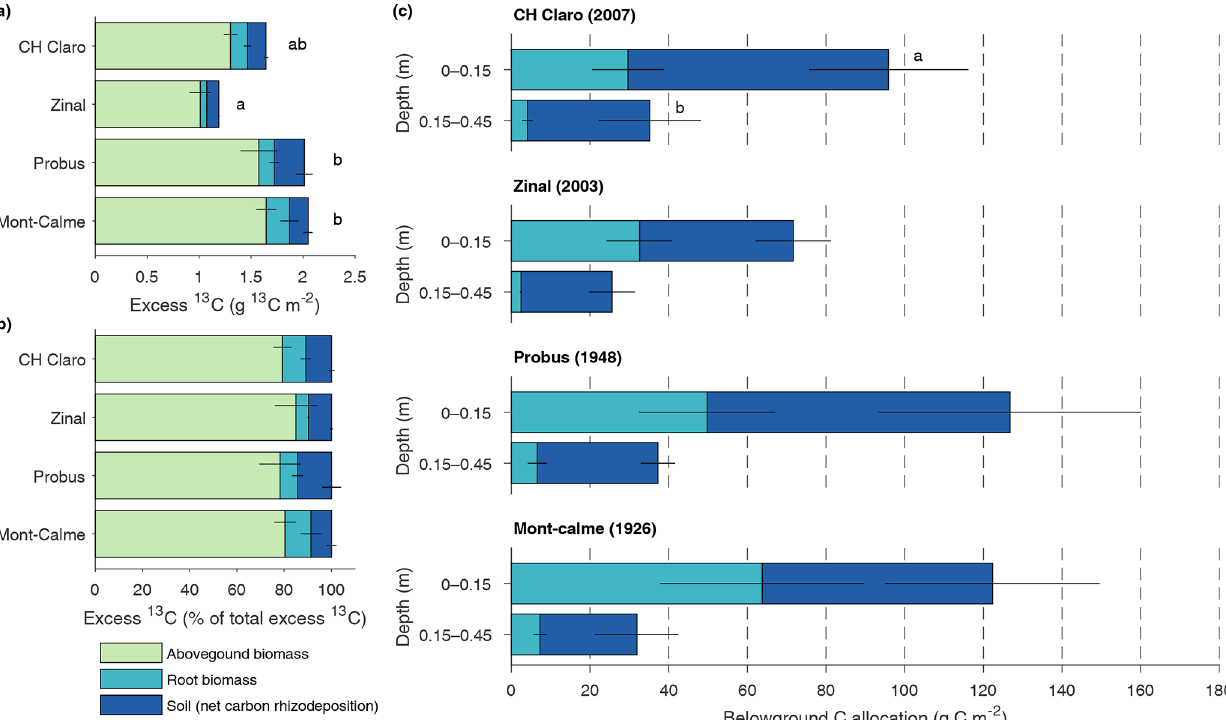
Figure 4. Absolute (a) and relative (b) distribution of excess 13 C between aboveground biomass, root biomass and soil for the different wheat cultivars. Soil compartments are calculated down to 0.45m depth. Panel (c) shows the total carbon rhizodeposition and root carbon for the upper two soil layers for the different wheat cultivars (0–0.45m depth). Error bars represent the standard error ( n = 3). In (a) , letters indicate significant differences between the total amount of excess 13 C of the different cultivars. No significant differences in the amount of excess 13 C in aboveground biomass, root biomass or soil between the different cultivars were found. In (c) , letters are provided when the total belowground C allocation differed between the different depth layers, which was only the case for CH